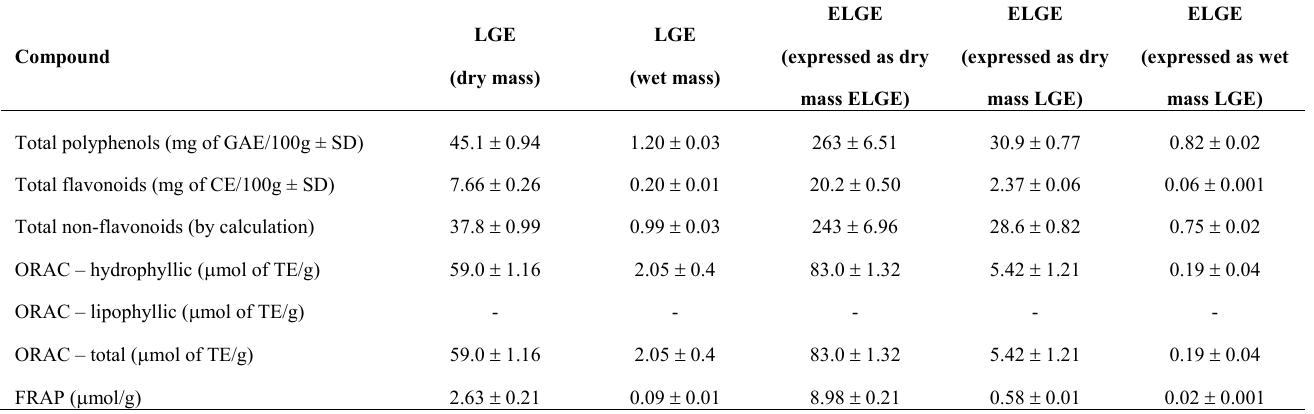
Table 2. Concentrations of Total Polyphenols, Flavonoids, Non-Flavonoids, Oxygen Radical Absorbance Capacity (ORAC) and Ferric Reducing Antioxidant Power (FRAP) in Lyophilized Aloe greatheadii var davyana Leaf Gel (LGE) and 95% Aqueous Ethanol Leaf Gel Extracts